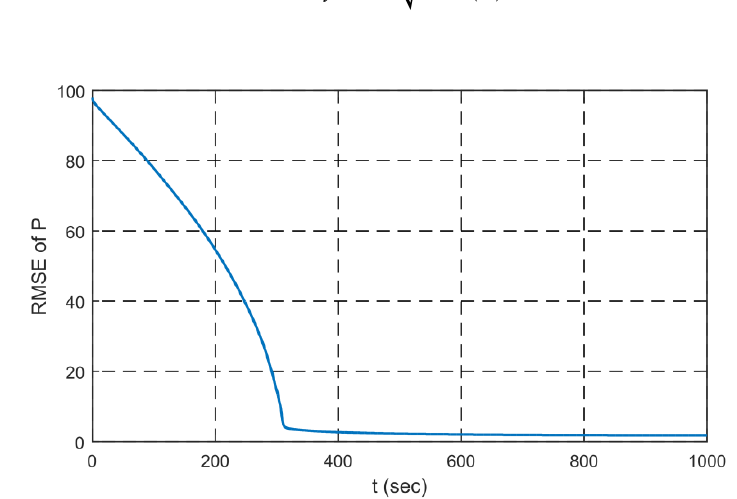
Figure 19. Evolution of P.